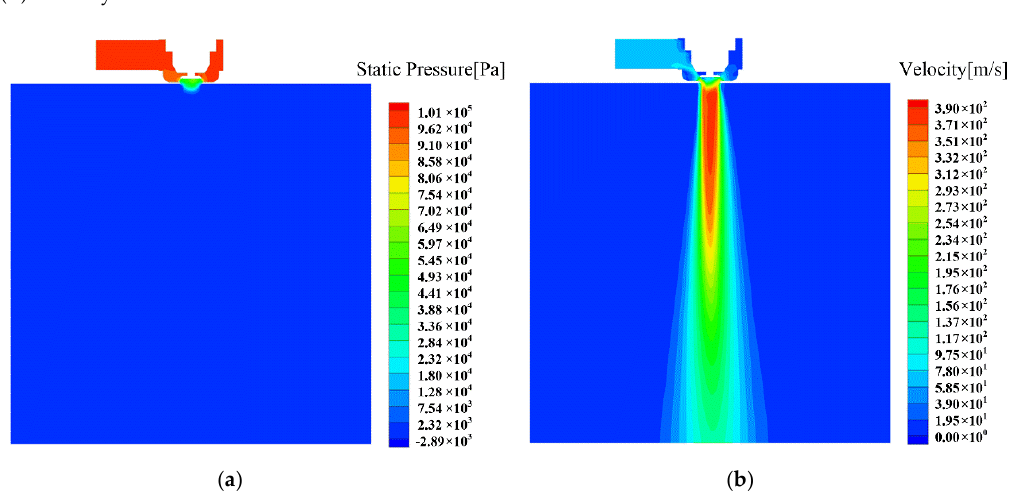
Figure 11. The outflow contour of the push-open injector. ( a ) Static pressure contour; ( b ) Velocity contour.